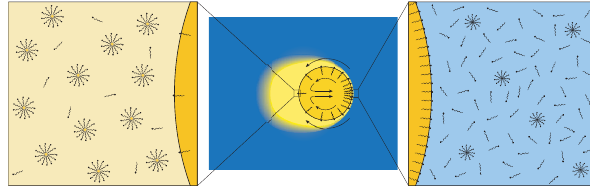
FIG. 1. Schematic of the mechanism at the origin of self- sustained droplet motion. Spontaneous symmetry breaking arises due to a higher concentration of monomers in equilibrium with the aqueous solution (on the right) compared to those facing DEP-saturated water (on the left). This effect arises because of the difference in the CMC in the two environments, and it causes a Marangoni flow, shown by the arrows, which is enhanced by droplet motion. soluble in water (1 mM), which lowers the CMC of SDS from 8 mM in pure water to 5 mM in the vicinity of the droplets. ¼ This decrease corresponds to a decrease in Δ G mic 2 . 3 k T log ð Δ CMC Þ ¼ 1 . 1 k T for the micellization energy B B